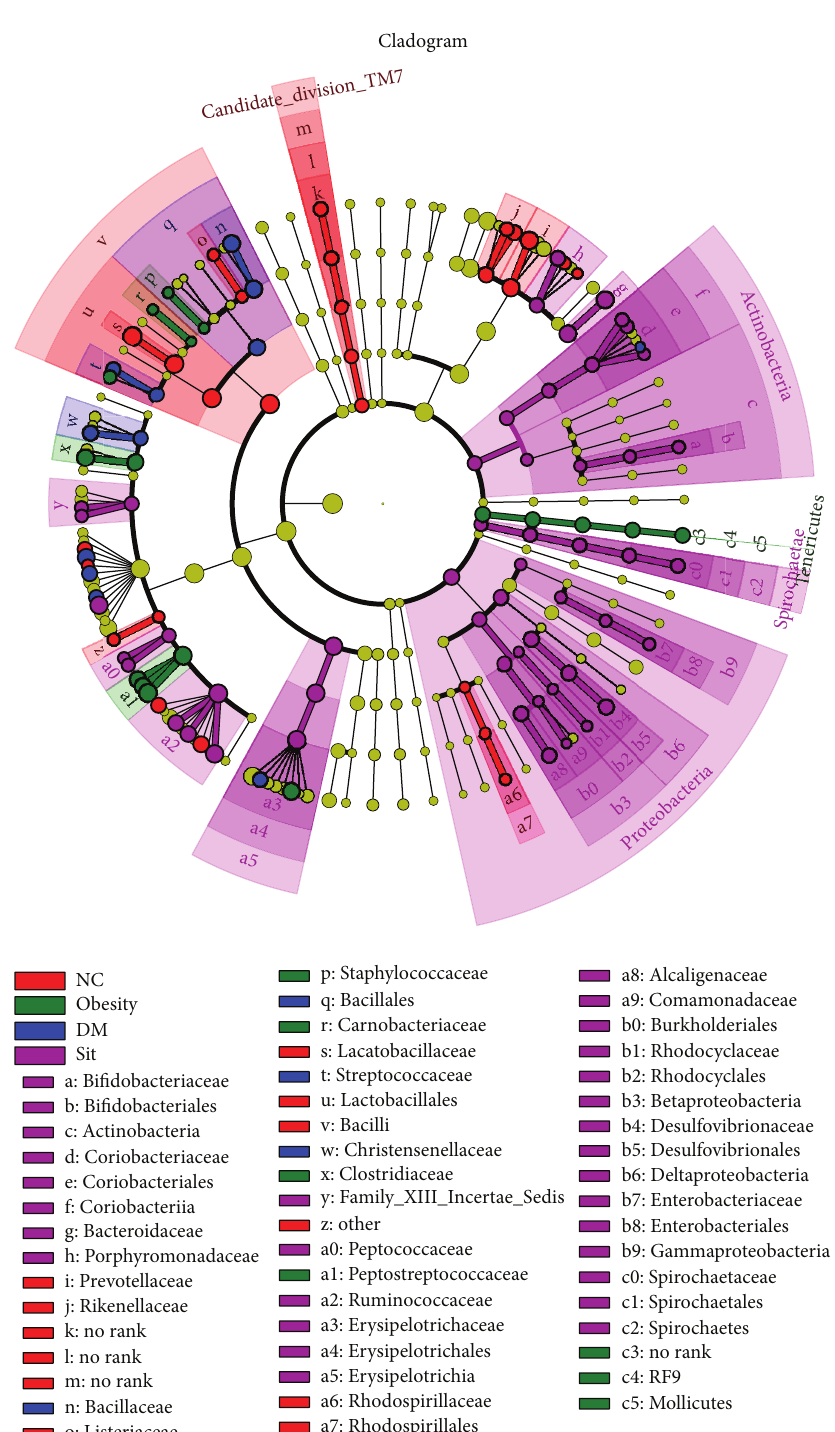
Figure 4: Taxonomic representation of statistically and biologically consistent differences among condition normal, obesity, diabetes, and sitagliptin. Differences are represented by the color of the most abundant class (red indicating normal condition, green obesity condition, blue diabetes condition, purple sitagliptin condition, and yellow nonsignificance). The diameter of each circle is proportional to the taxon’s